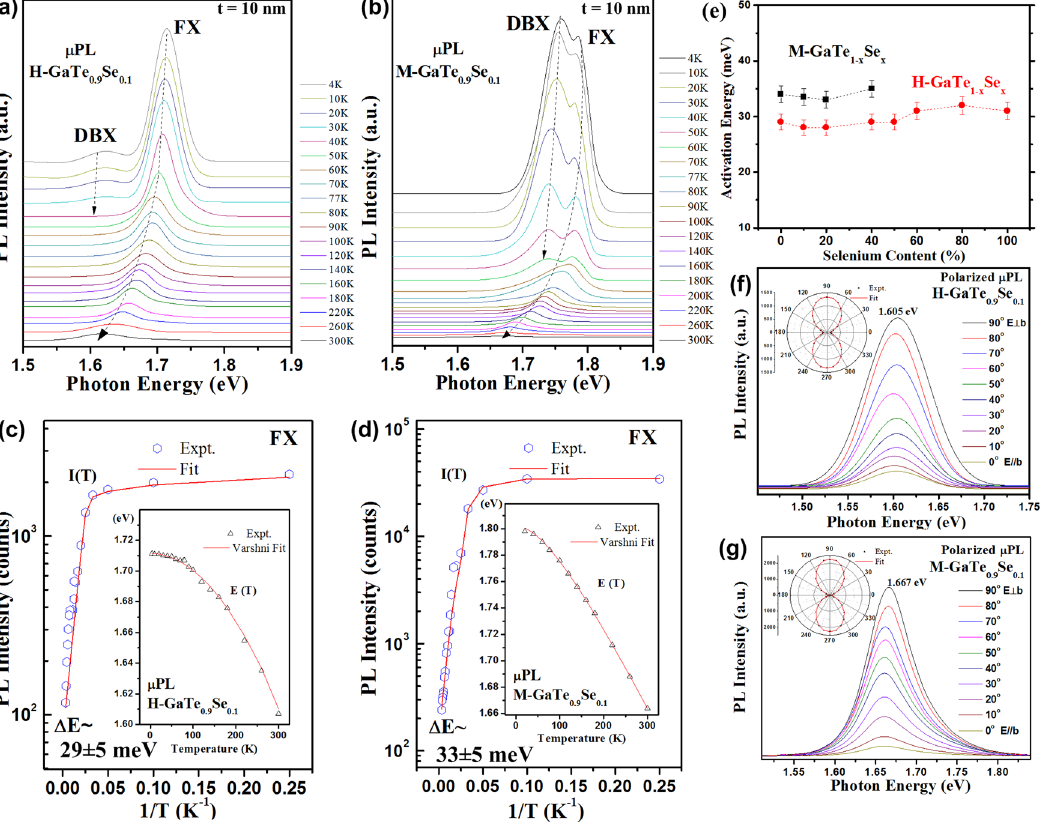
Fig. 2 Temperature- and polarization-dependent μ PL results and the TRPL decay lifetime. Temperature-dependent μ PL spectra of a selected multilayer sample of GaTe 0.9 Se 0.1 in ( a ) H phase and ( b ) M phase with thickness ~10 nm between 4 and 300 K. c PL intensity versus reciprocal temperature for obtaining binding energy of ( c ) hexagonal GaTe 0.9 Se 0.1 and ( d ) monoclinic GaTe 0.9 Se 0.1 . The respective insets show the temperature dependencies of the free-exciton transition energies of M-GaTe 0.9 Se 0.1 and H-GaTe 0.9 Se 0.1 between 4 and 300 K. e Obtained activation energies of full-series M-GaTe 1 − x Se x (0 ≤ x ≤ 0.4) and H-GaTe 1 − x Se x (0 ≤ x ≤ 1) from temperature-dependent μ PL measurement. Angular-dependent polarized µPL spectra of ( f ) H-GaTe 0.9 Se 0.1 and ( g ) M-GaTe 0.9 Se 0.1 implemented at 300 K to reveal the distinction in in- plane anisotropy. The respective insets show the polar plots of the angular-dependent polarized PL intensity